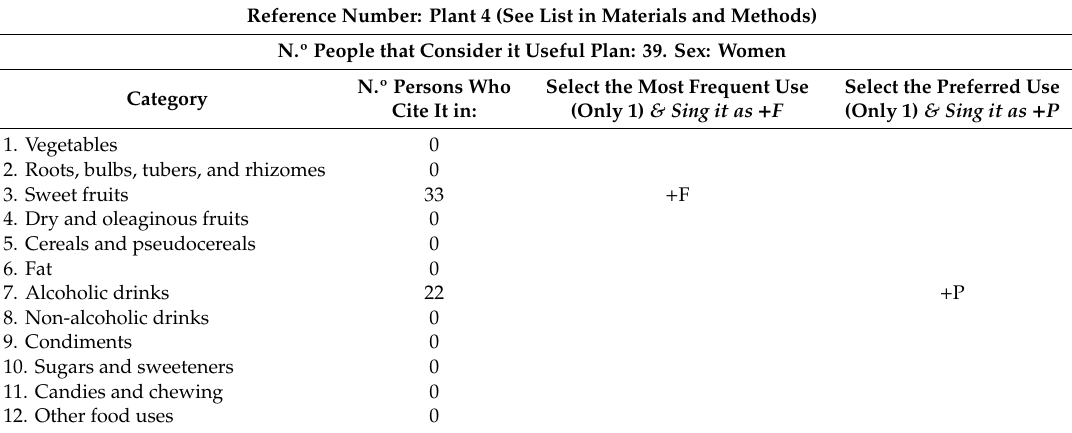
Table 1. Table design, with sample